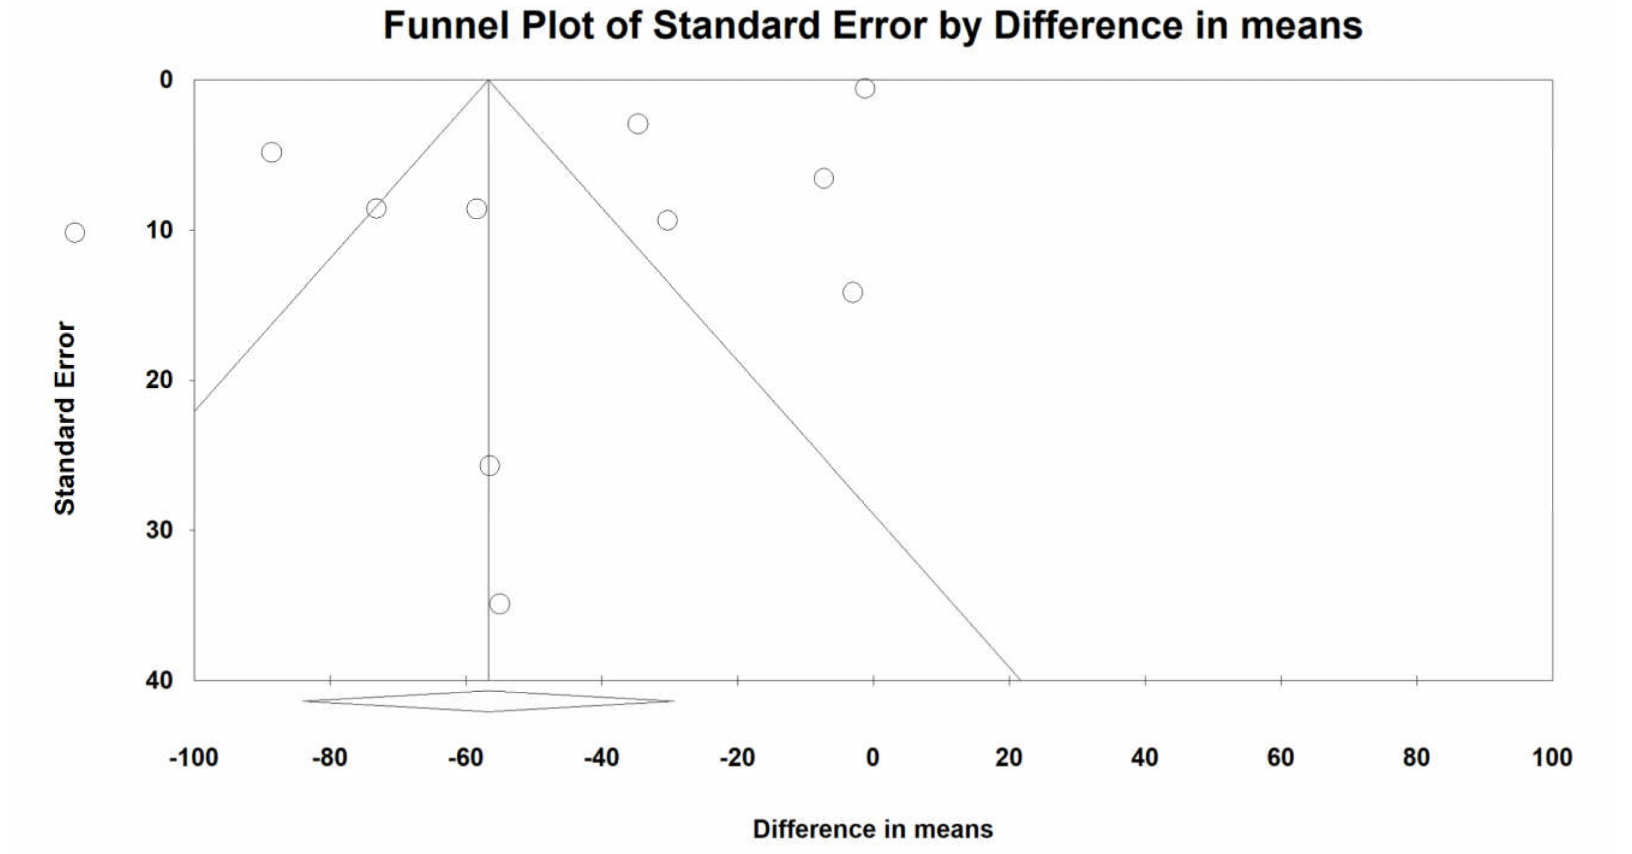
Figure 5. Funnel plot for crying time (DM) in present